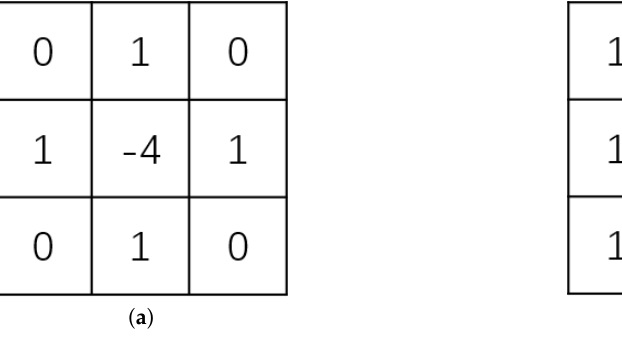
Figure 5. ( a ) Four-neighbor template and ( b ) eight-neighbor